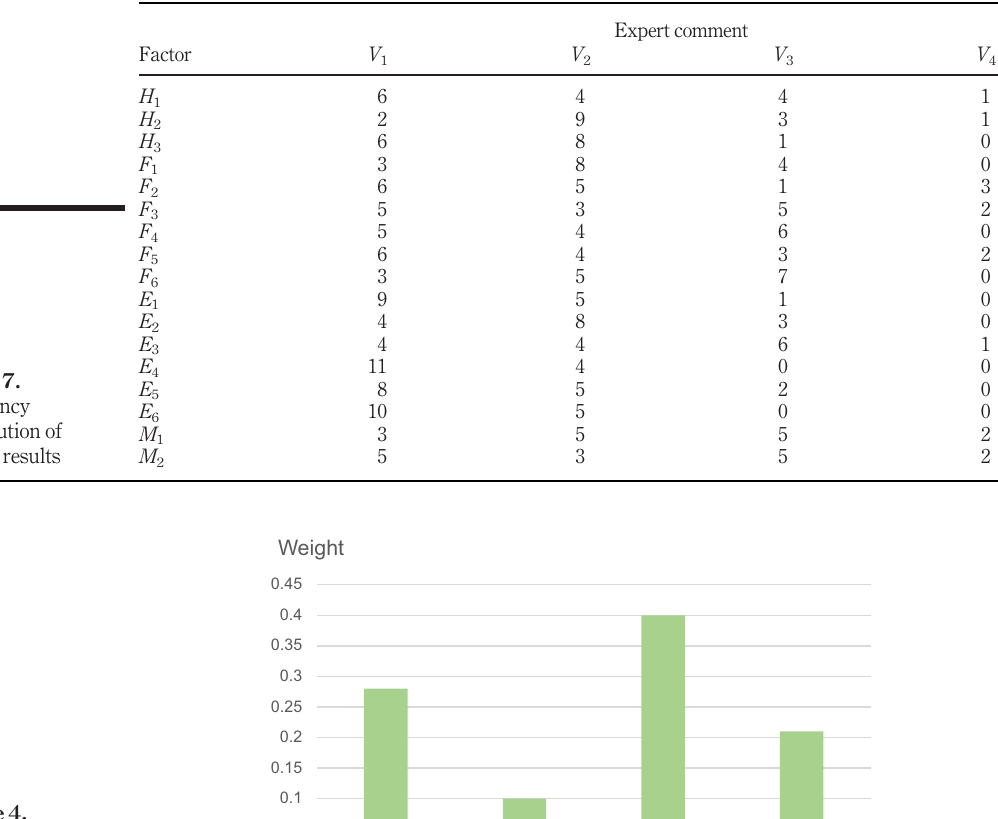
Figure 4. Weight distribution of primary evaluation